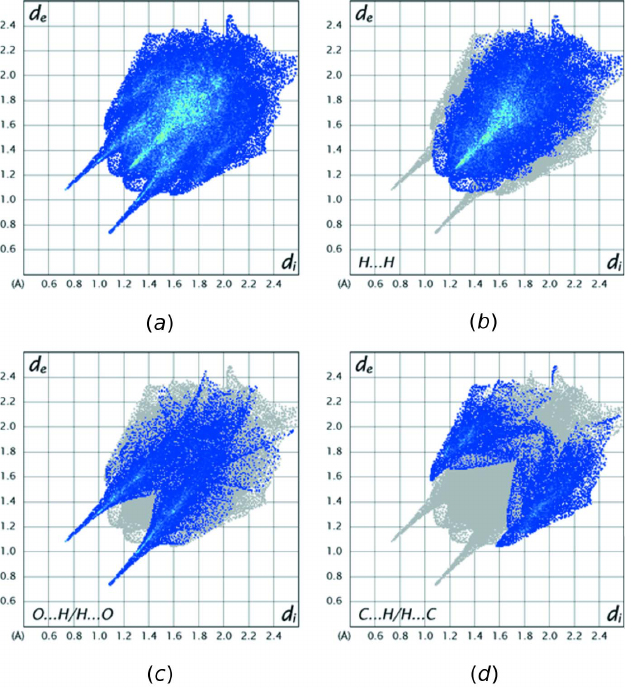
Figure 5 Fingerprint plots for the title molecule: ( a ) all contacts, ( b ) H (cid:2)(cid:2)(cid:2) H contacts, ( c ) O (cid:2)(cid:2)(cid:2) H/H (cid:2)(cid:2)(cid:2) O contacts and ( d ) C (cid:2)(cid:2)(cid:2) H/H (cid:2)(cid:2)(cid:2) C